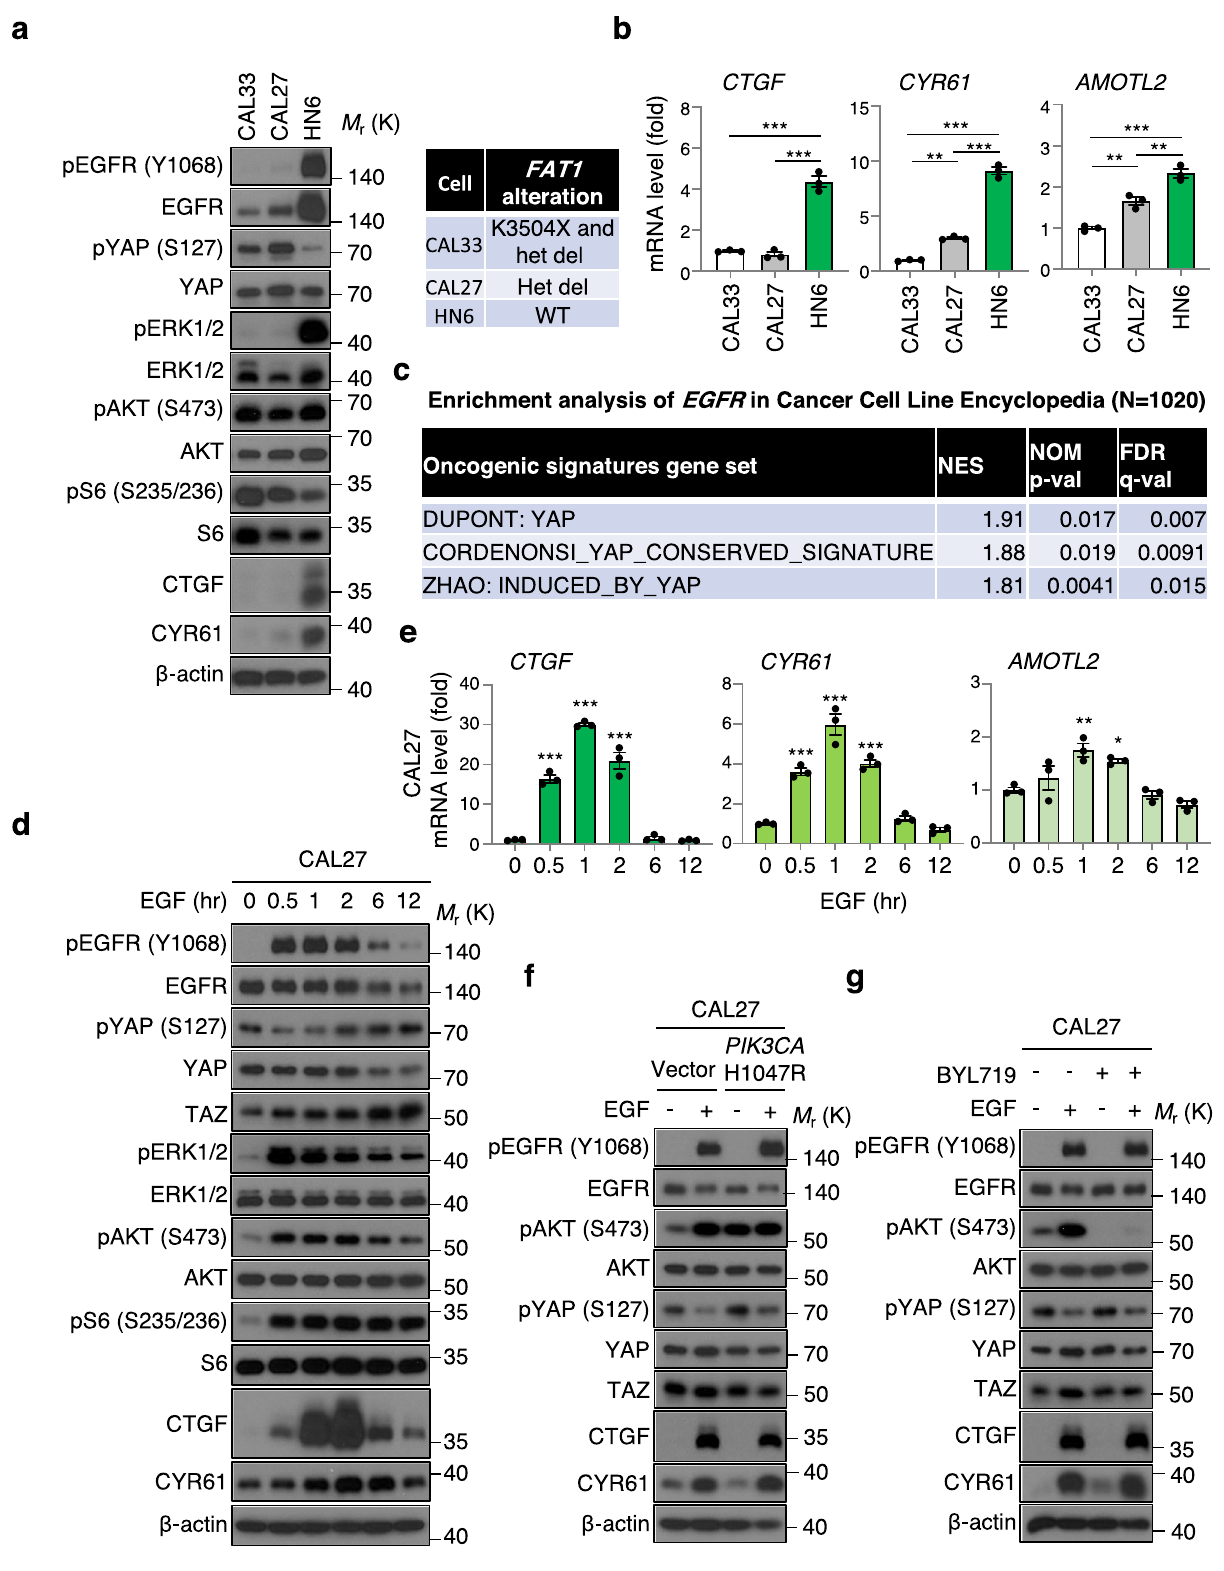
Reconstituted EGFR expression induces hypo-phosphorylation and nuclear translocation of YAP/TAZ, thereby enhancing transcription of YAP/TAZ-regulated genes . To examine the precise mechanism by which EGFR activates YAP/TAZ, we established EGFR-overexpressing HEK293A cells, recapitulating HNSCC and other EGFR overexpressing cancer types. Vector-